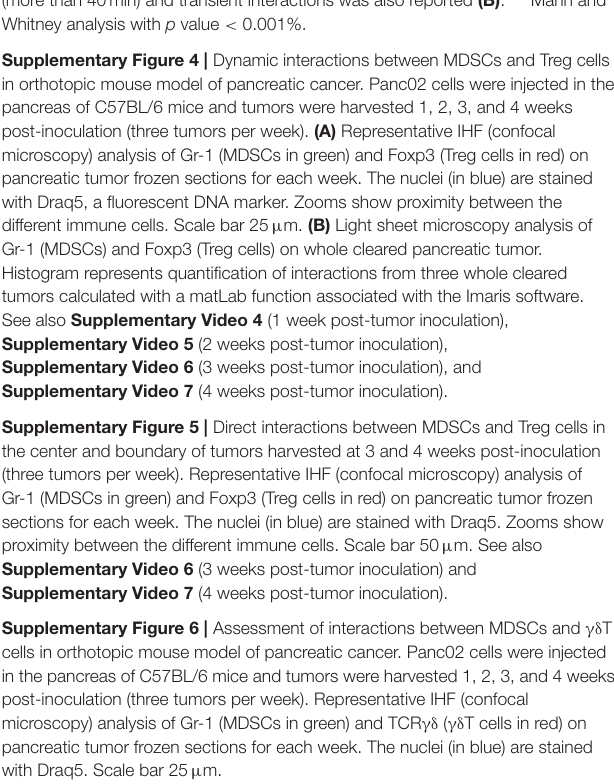
pancreas and spleens were harvested 3 weeks post-inoculation. Spleens from naive mice were used as controls. Flow cytometry analysis of (A) the surface molecules CD127, CCR5, CTLA4, TGF- β , and CD103 on Treg (CD45 + CD4 + Foxp3 + ), (B) the activation markers CD62L and CD69, as well as the intracellular expression of IFN- γ on CD4 + and CD8 + T cells. Gray histograms represent isotype control and red histograms specific staining as indicated. Percentage of positive cells are shown. Three independent experiments have been performed. Representative dot plots and histograms for one are shown. Supplementary Figure 3 | Assessment of MDSC and Treg interactions in pancreatic tumors by videomicoscopy. Treg (CD4 + CD25 + ) cells purified both from spleen or pancreas of tumor-bearing mice were loaded with FITC cell tracker and incubated with tumoral MDSCs for 10h. Microscopic acquisition was performed every 20min (A) and the percentage of total CD4 + CD25 + cells bound to MDSCs was quantified 5 and 10h post-co-culture. The ratio of persistent interactions